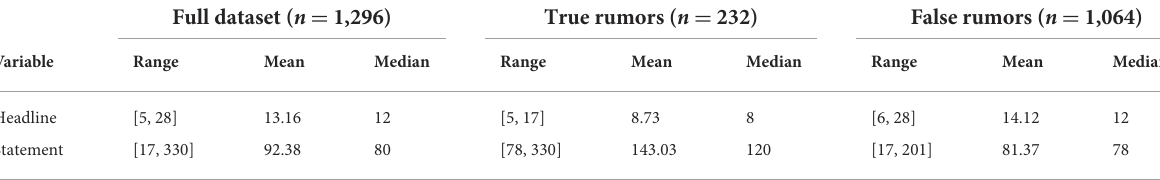
TABLE 3 Descriptive statistics of information length.